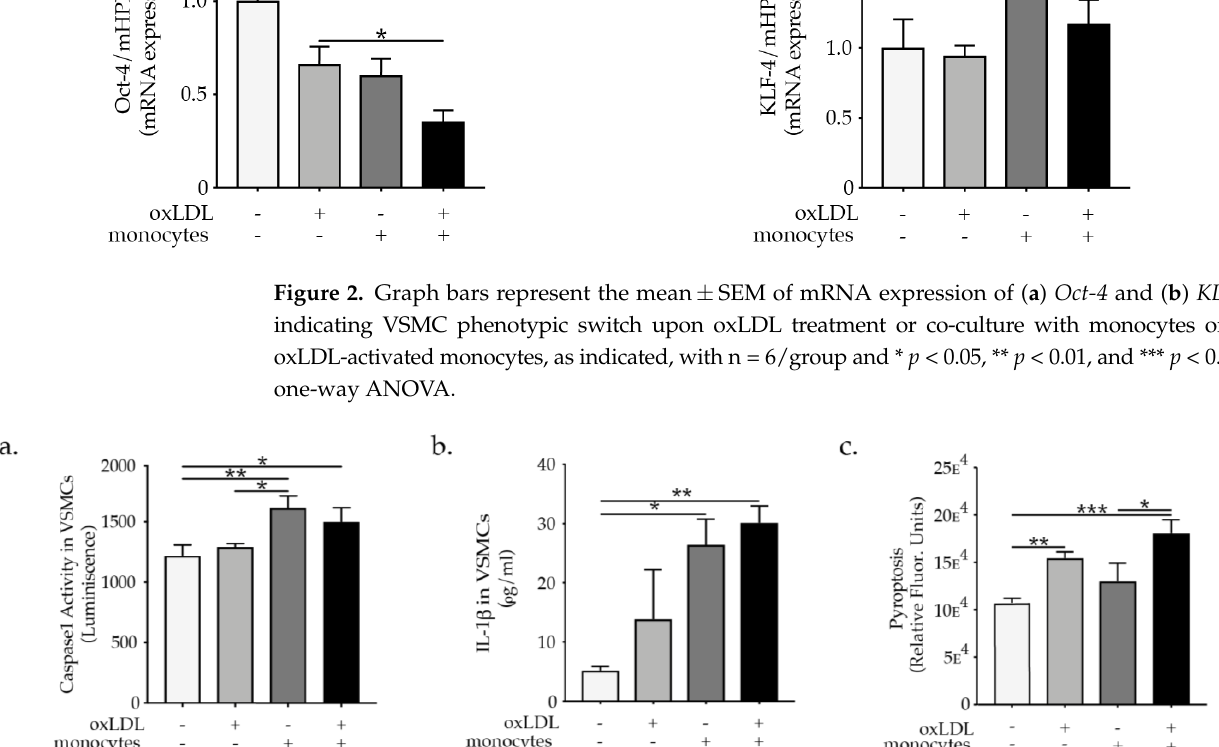
Figure 3. Graph’s bar represent the mean ± SEM of ( a ) caspase 1 activation, ( b ) IL-1 β secretion, and ( c ) pyroptosis in VSMC upon oxLDL treatment or monocytes or oxLDL-activated monocytes supplementation as indicated, with n = 6/group and * p < 0.05, ** p < 0.01, and *** p < 0.001, one-way ANOVA.